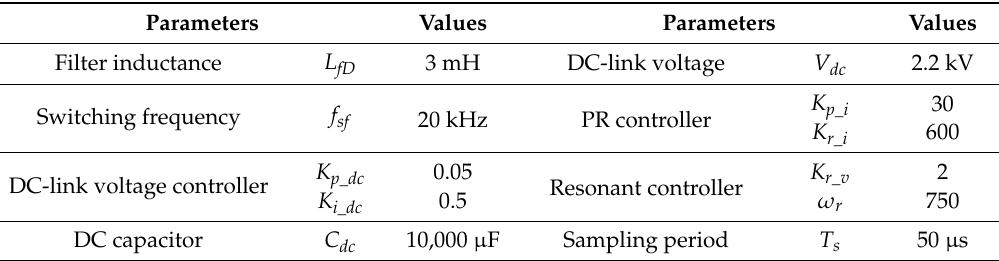
Table A4. Simulation parameters of the selective harmonic damping (SHD)